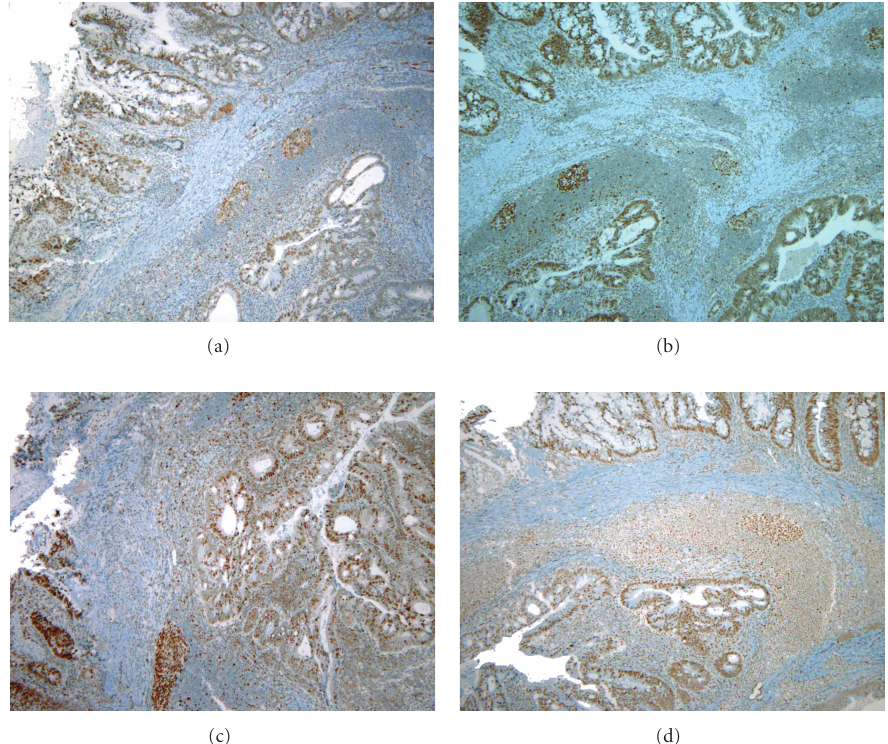
Figure 3: Immunohistochemical analysis of MLH-1, MSH-2, MSH-6, and PMS-2 protein expression in the DC. The neoplastic cells and the internal control (lymphocytes) are positive (a) for MLH-1 ( × 40), (b) for MSH-2 ( × 40), (c) for MSH-6 ( × 40), and (d) for PMS-2 ( ×